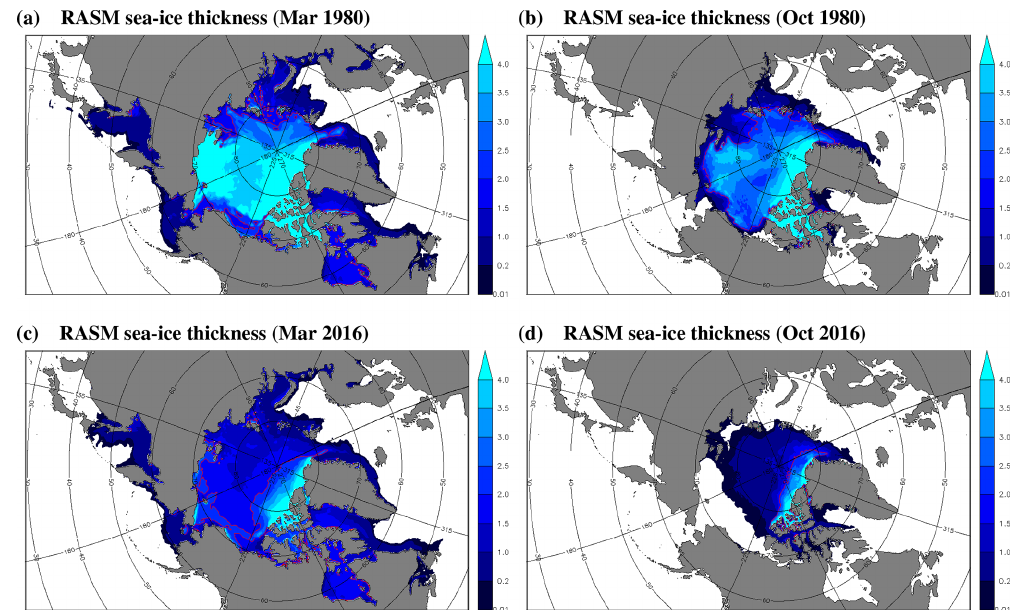
Figure 19. Similar to Fig. 18 but for the RASM results. The red contour in this case indicates 2m ice thickness from the model results. Note that color-bar values are identical to those in Fig.